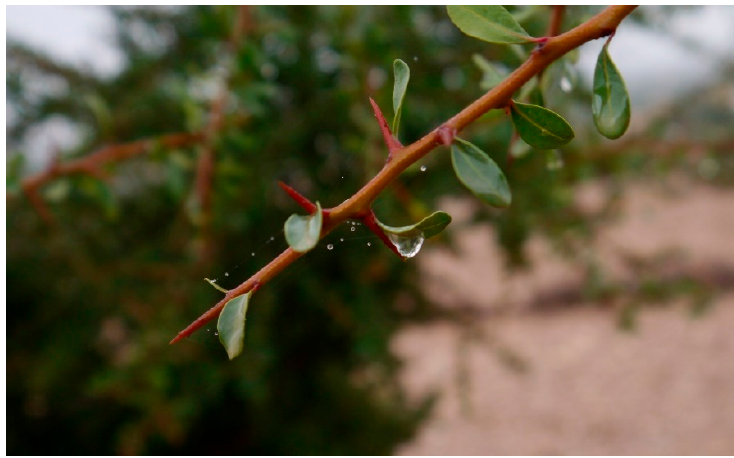
Figure 13. Collection of fog precipitation by the argan tree.